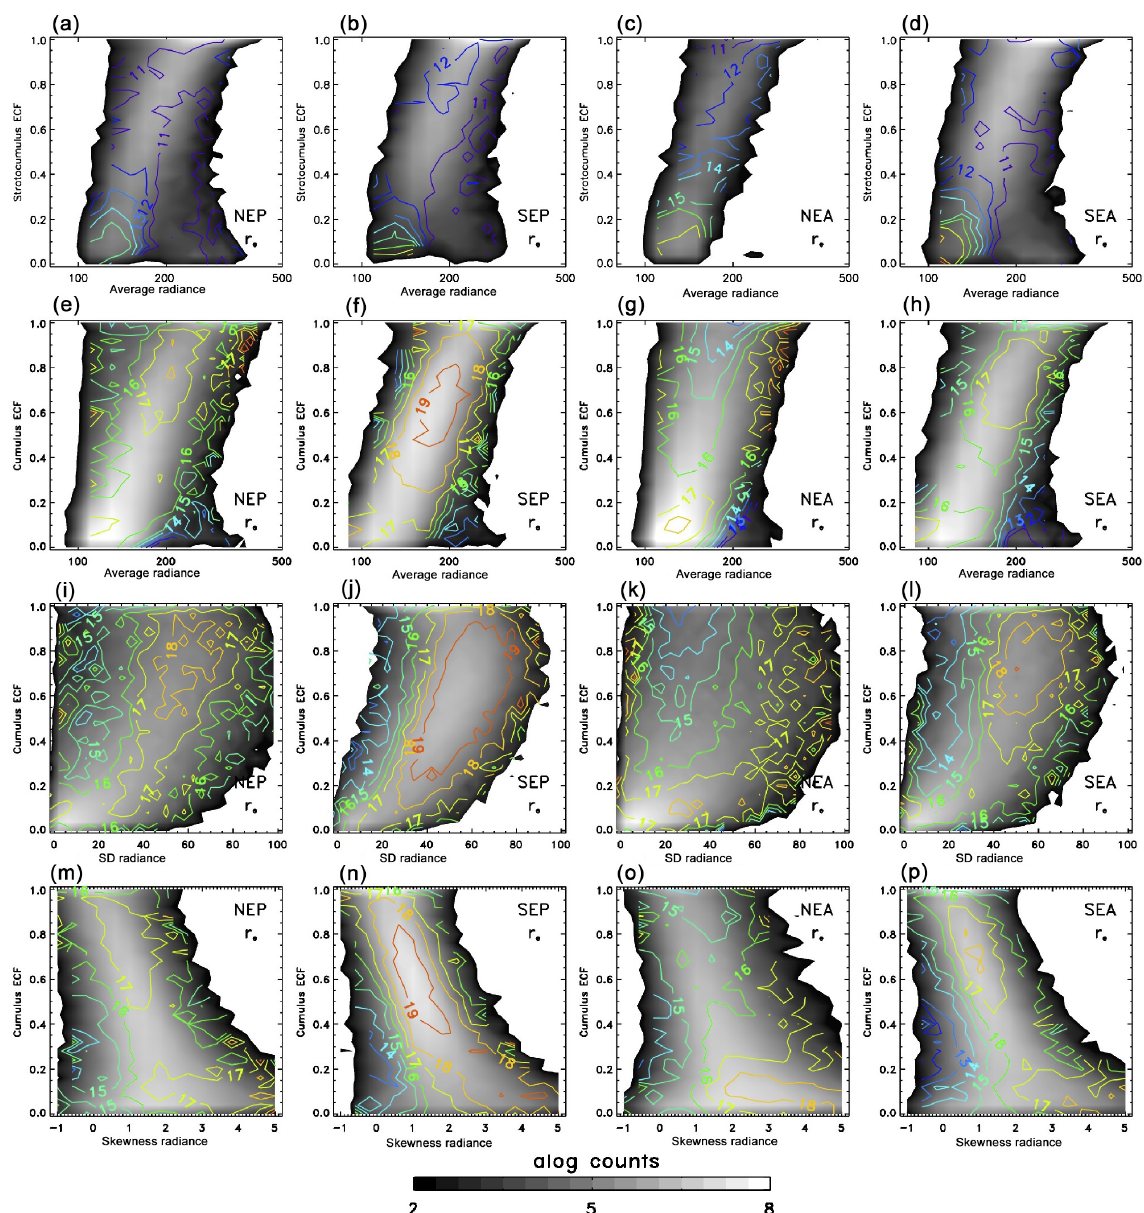
Figure 10. Joint PDFs of visible radiance skewness versus ECF for the four regions listed in Table 1; the overlay field is r e